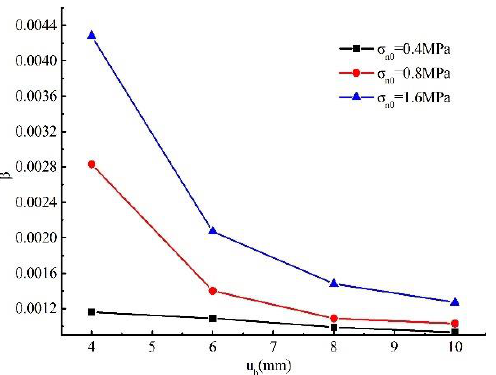
Figure 11. Relationship curves of shear displacement ( u h ) and Forchheimer coefficient.